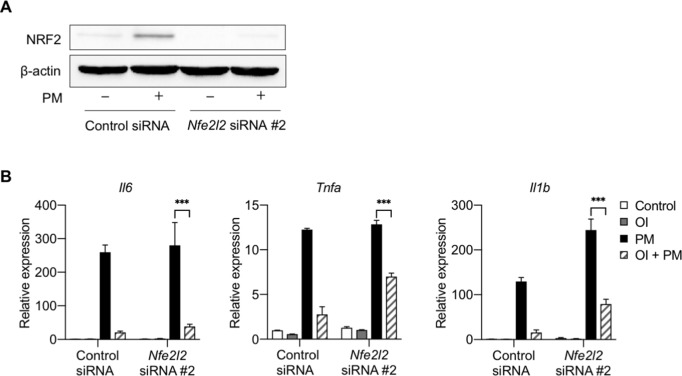
NRF2 is not required for the anti-inflammatory effects of exogenous itaconate (OI) on PM-induced inflammatory response.(A) Western blot of NRF2 protein in BMDMs transfected with scramble control or Nfe2l2 siRNA (#2), then treated with PM (20 µg/cm2) for 4 hours. NRF2 protein is induced by PM in cells with control siRNA, but not with Nfe2l2 siRNA. (B) qPCR of pro-inflammatory cytokine genes (Tnfa, Il6 and Il1b) in control or Nrf2 siRNA (#2) transfected BMDMs treated with PM (20 µg/cm2) for 4 hours, with or without OI pretreatment (0.25 mM, for 2 hours). Significance of qPCR was analyzed with one-way ANOVA corrected with Bonferroni’s post hoc test for multiple comparisons, n = 3; *p<0.05, **p<0.01, ***p<0.001.